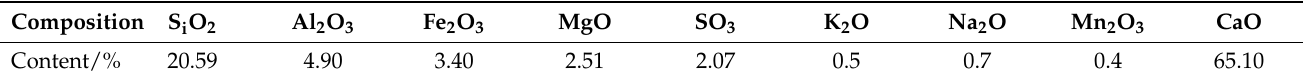
Table 2. Main chemical composition of cement.